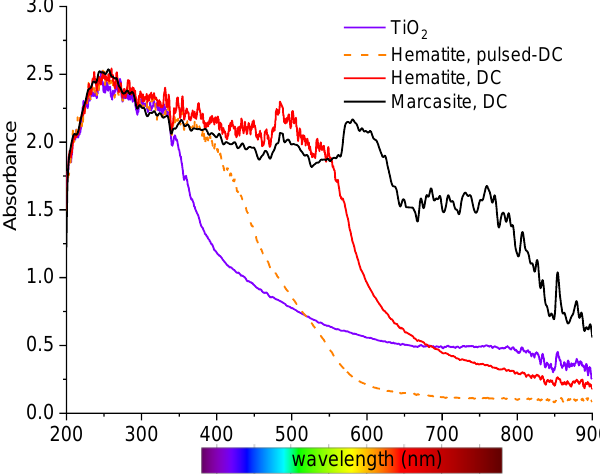
Figure 8. Absorbance spectra of hematite and marcasite films. TiO 2 film shows for comparison.